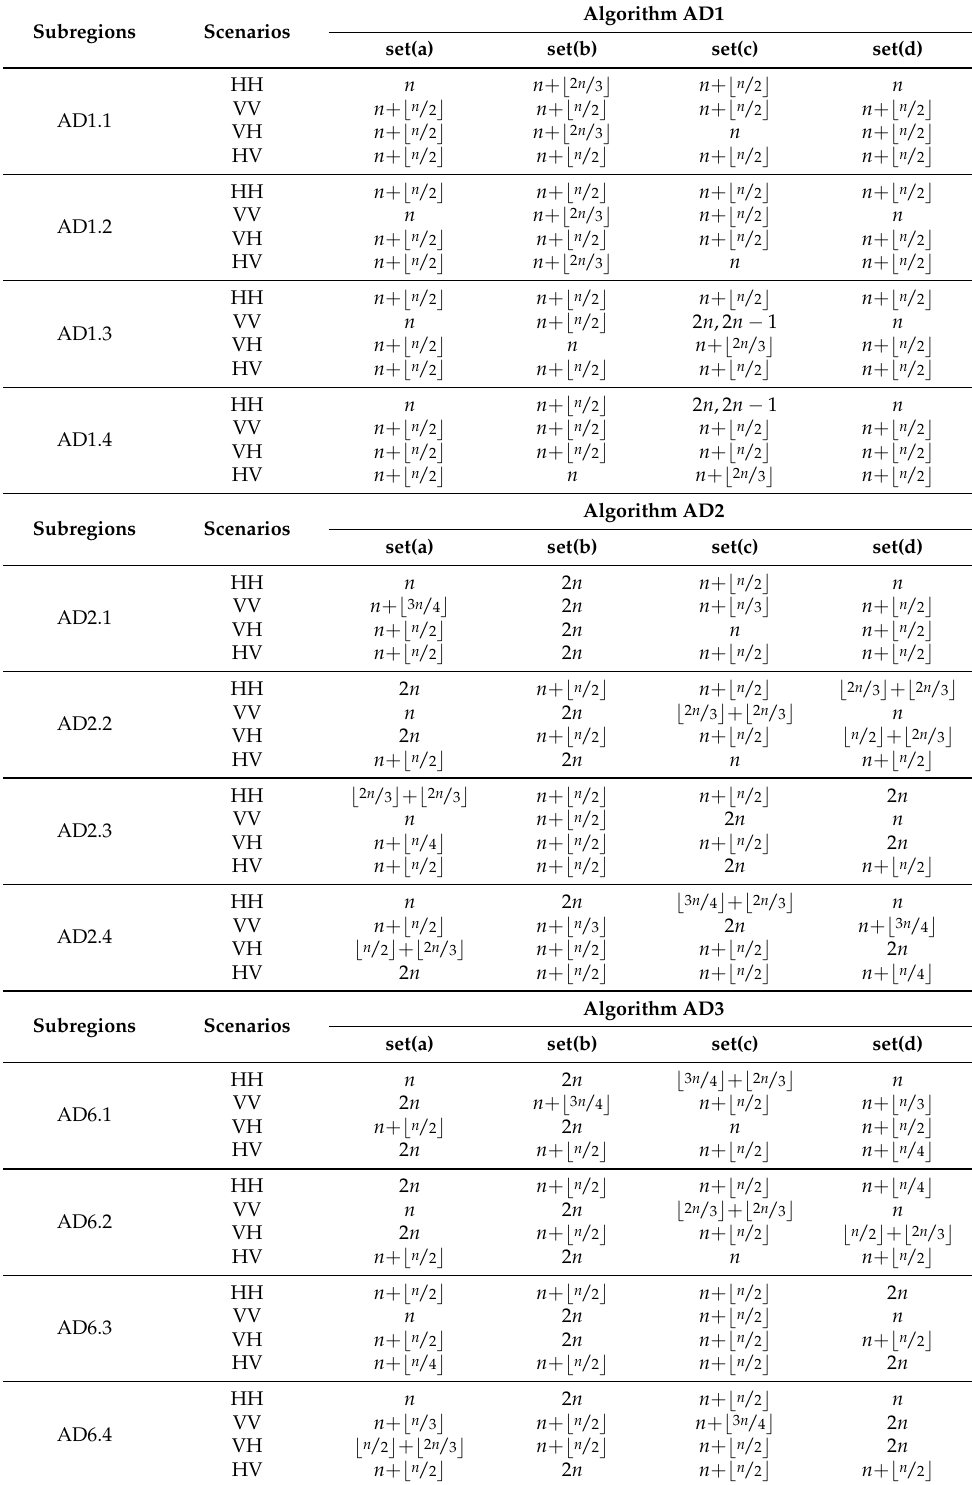
Table 2. AD1 Algorithm scenarios